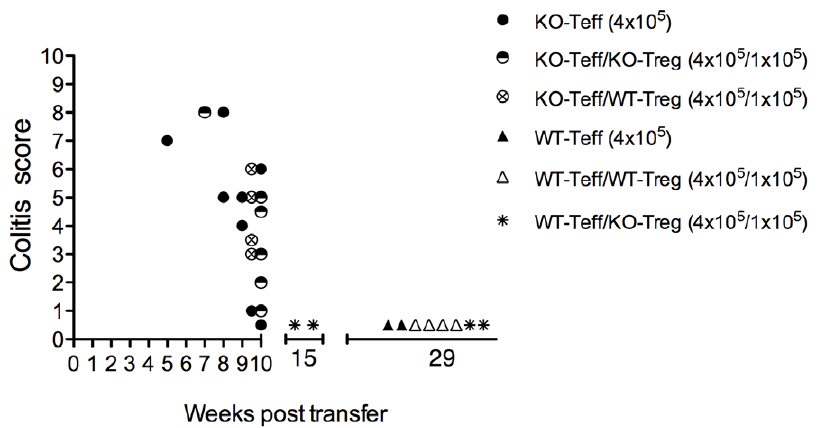
Figure 5. Treg from colitic G a i2 2 / 2 mice fail to protect against colitis in a transfer model. Freshly isolated and sorted donor splenic CD4 + CD25 2 Teff cells from colitic G a i2 2 / 2 mice (KO-Teff) or CD4 + CD25 2 effector T cells from WT mice (WT-Teff) were transferred with or without splenic CD4 + CD25 + Treg from G a i2 2 / 2 mice with colitis (KO-Treg) or WT CD4 + CD25 + Treg (WT-Treg) at a 4:1 (Teff:Treg) ratio into RAG2 2 / 2 recipients by i.p. injection. The results are based on three separate